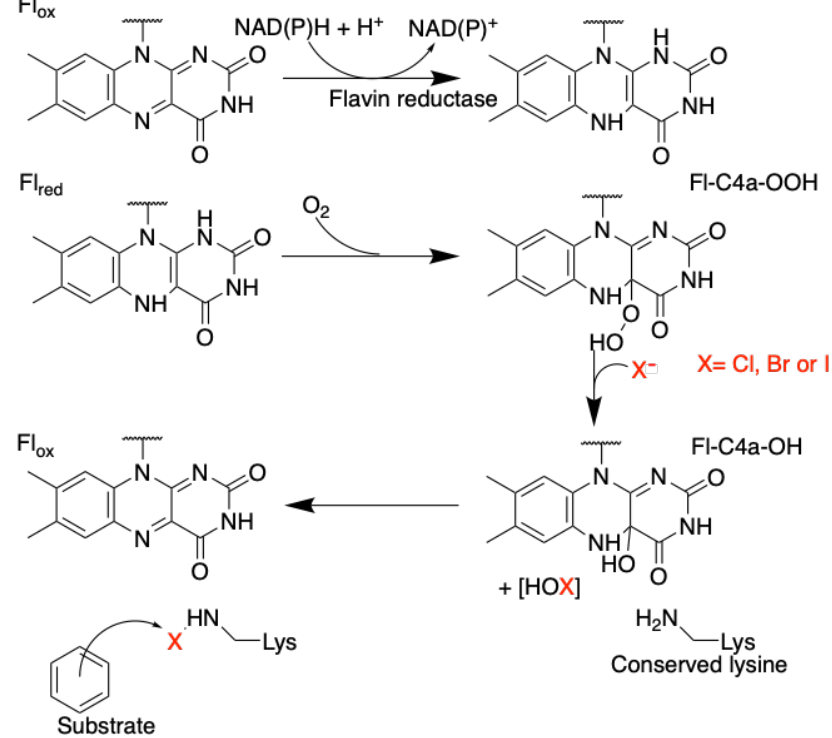
Figure 10. FDH schematic reaction mechanism inspired by